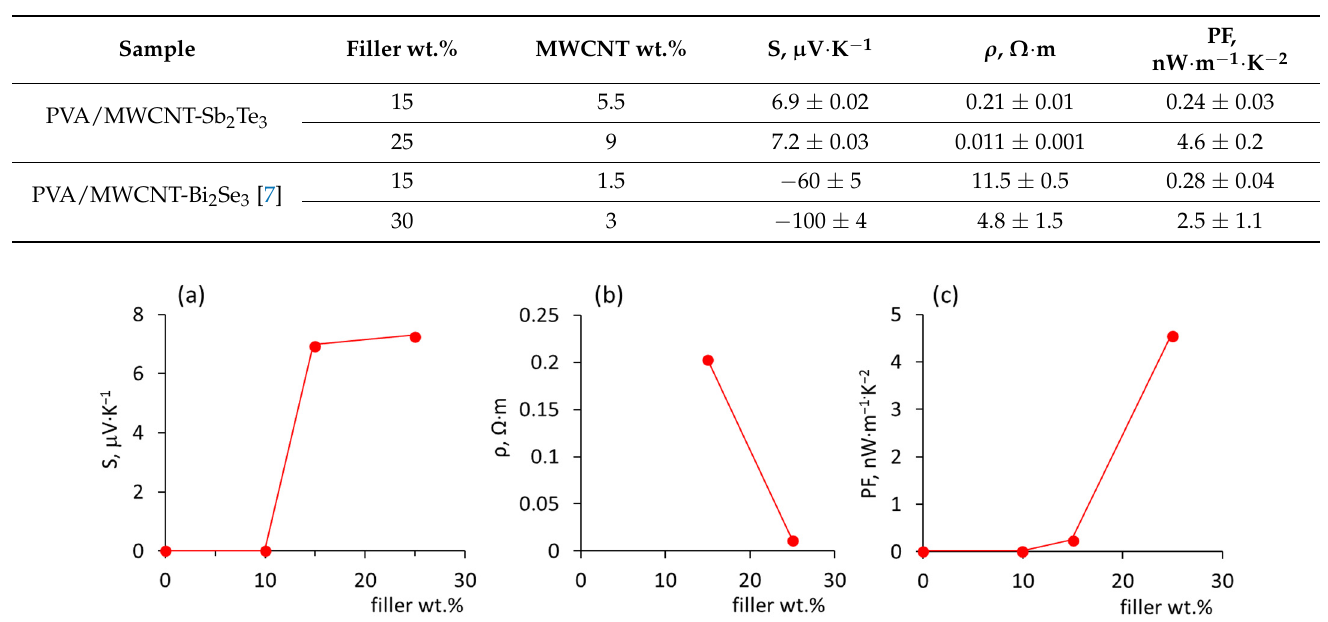
Table 1. Comparison of electrical resistivity, Seebeck coefficient and power factor of PVA-based composites with different types of fillers.